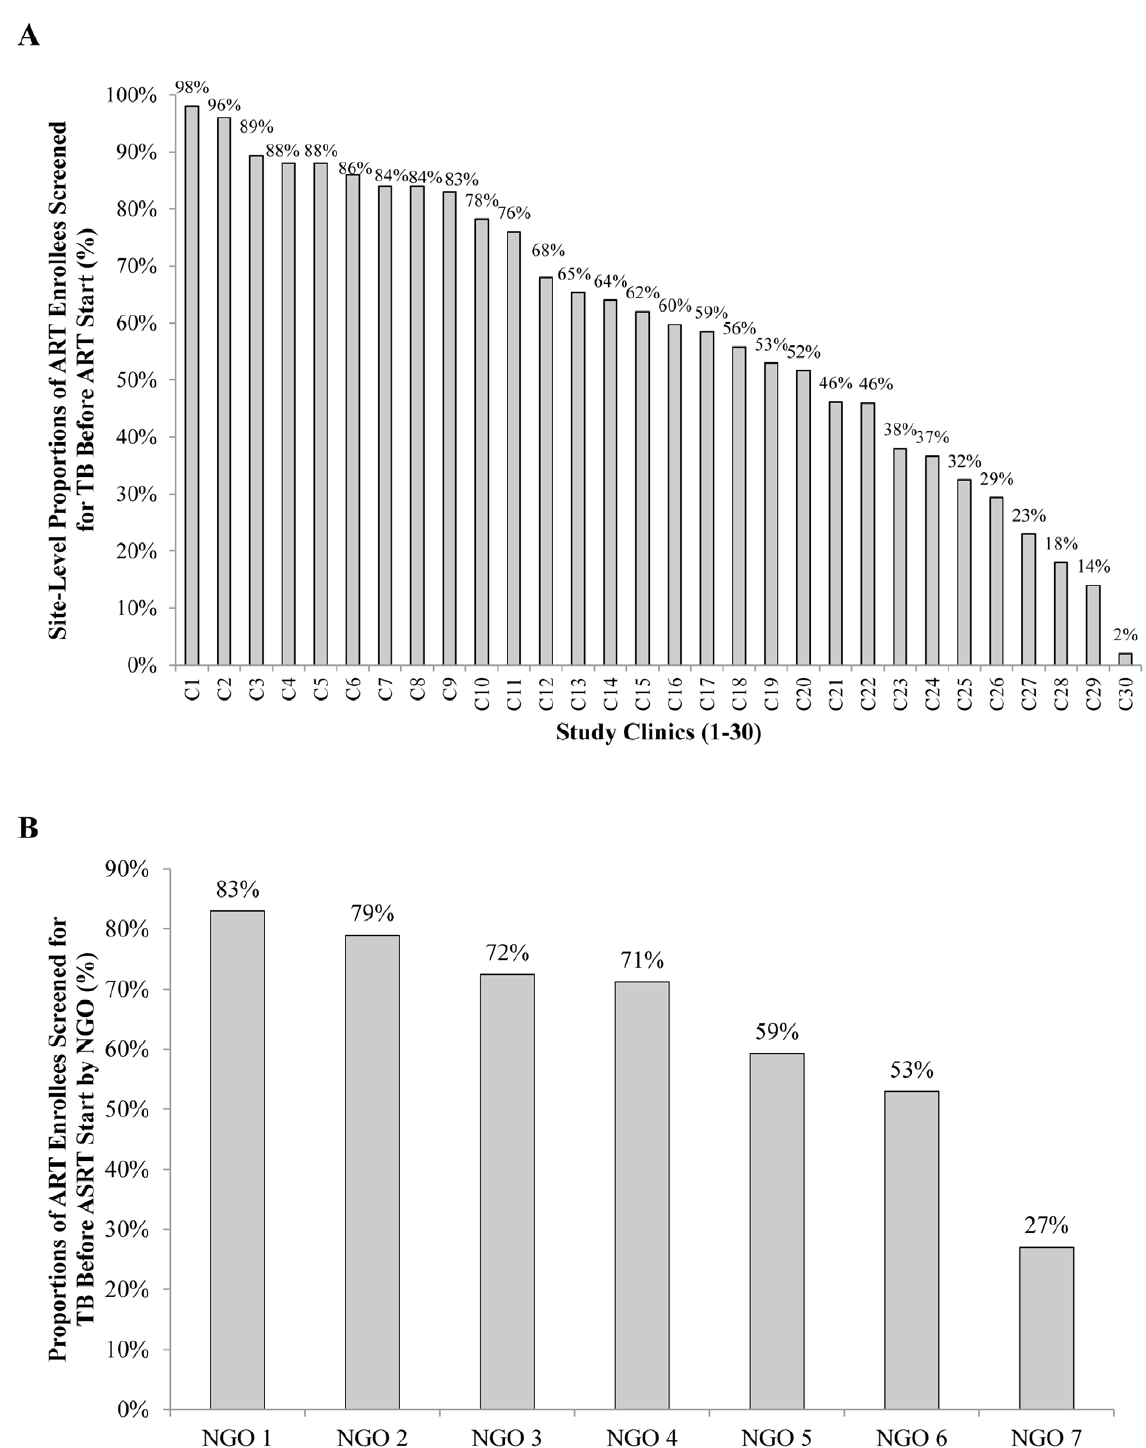
Figure 2. Compliance with TB Screening at ART Enrollment by Clinic and Supporting Non-Governmental Organization. A Compliance with TB Screening Guidelines According to ART Clinic (n=2,596). Chi-square test: p , 0.001. B Compliance with TB Screening Guidelines According to Primary Non-Governmental Agency Supporting the ART Clinic (n=2,596). Chi-square test: p , 0.001. doi:10.1371/journal.pone.0054665.g002 incidence rates did not vary significantly across 3-monhtly ART Baseline characteristics associated with increased risk of TB follow-up intervals (figure 3). incidence included a 10-year age increase [adjusted hazards ratio (AHR) 1.40; 95% CI, 1.23–1.60] (table 2). Compared with